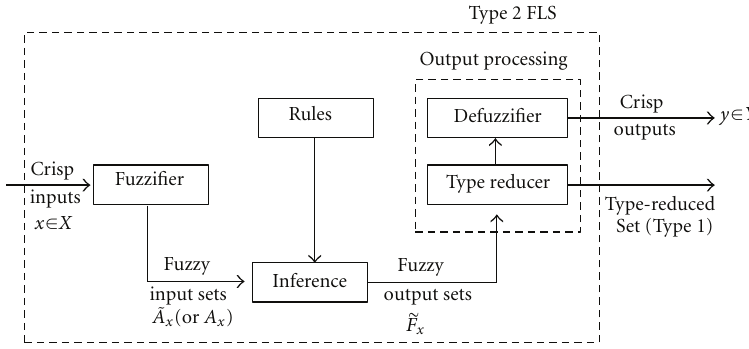
Figure 3: Diagram of type 2 fuzzy logic system [4].